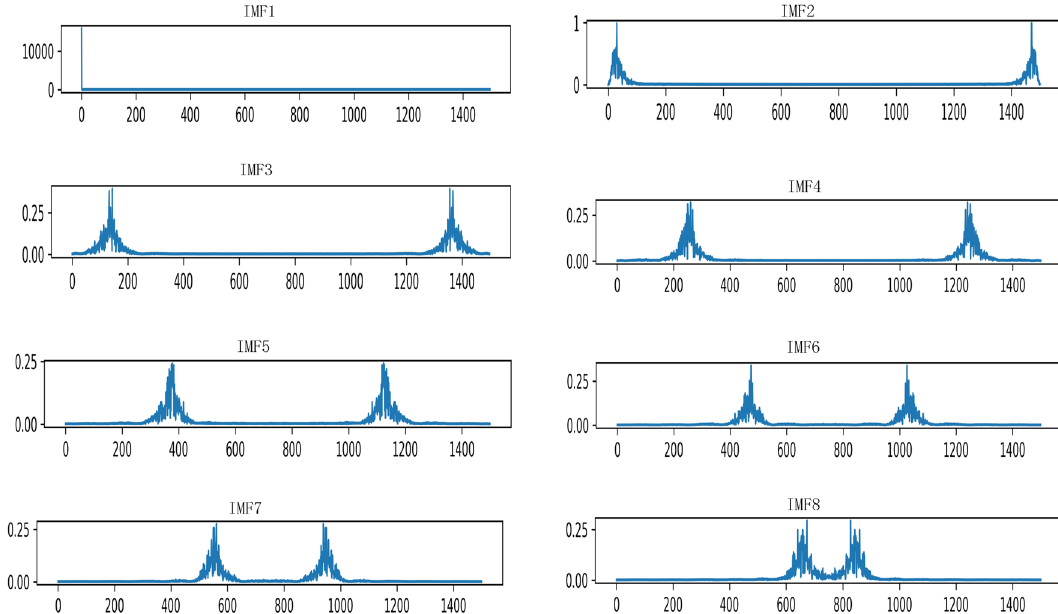
Figure 8. The center frequency diagram decomposed into 8 IMFs.